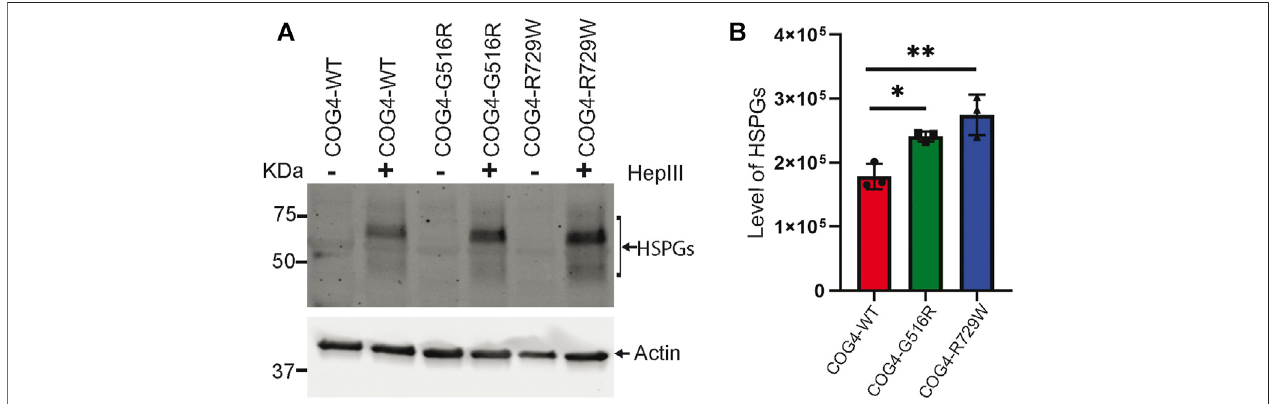
FIGURE 7 | Increased accumulation of core proteins of HSPGs (Heparin sulfate proteoglycans) on the cell surface of rescued mutant (G516R and R729W) RPE1 cell line. (A) RPE1 rescued COG4-WT-3myc, COG4-G516R-3myc, and COG4-R729W-3myc cells were digested by the Heparinase III enzyme. Western blot analysis with 3G10 antibody to the core proteins of proteoglycan (HSPGs). (B) Quantitative analysis of the core proteins of HSPGs accumulation. Statistical signi fi cance was calculated by GraphPad Prism 8 using One-way ANOVA. ** p ≤ 0.01, *** p ≤ 0.001. Error bar represents mean ±